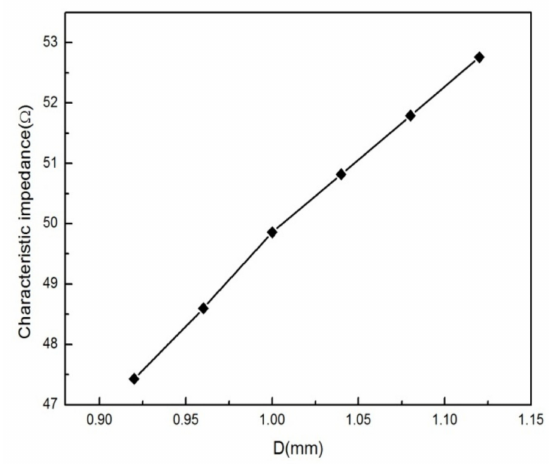
Figure 9. Parameter D sweeping results.